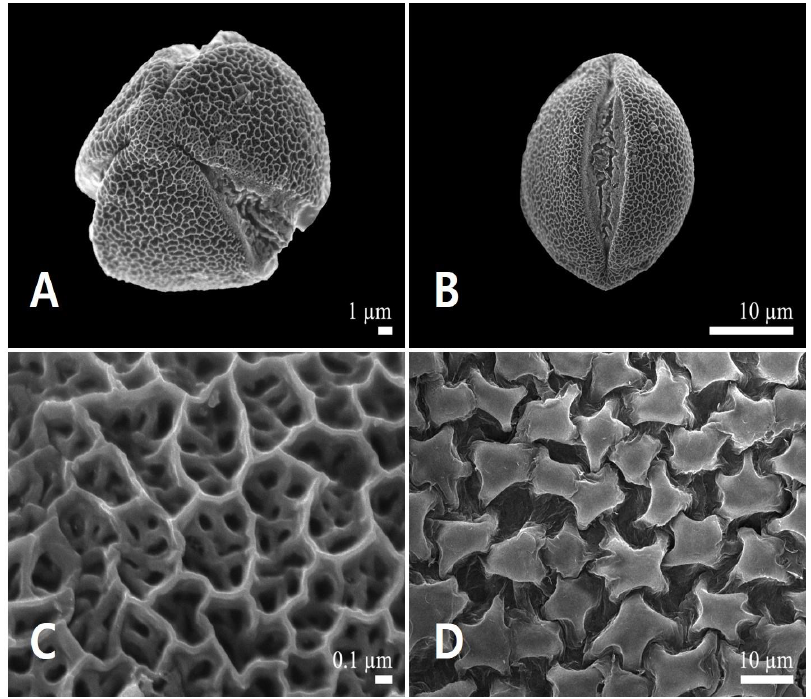
Figure 9. Scanning electron micrographs of pollen and the inner locule wall in Leonurus macranthus . ( A ) Polar view of a pollen grain. ( B ) Equatorial view of a pollen grain. ( C ) Exine surface ornamentation. ( D ) Inner locule wall. 3.3. Floral Trichome Diversity Trichome characteristics, such as distribution, type, length, density, and surface or- namentation, were verified. Three basic types of trichomes were observed on the calyx lobe and tube, upper and lower lips, and filament: capitate stalked glandular trichomes, peltate glandular trichomes, and non-glandular simple trichomes. Scale-like glandular tri- chomes were found only on the anther. 3.3.1. Glandular Trichomes Three shapes of glandular trichomes were identified: capitate stalked, peltate, and scale-like glandular trichomes. Capitate stalked glandular trichomes ( C , Figures 2A,B,D – F,H and 3C,D) had one (Figures 3C and 10D), three (Figure 10B), four (Figure 3D), or eight cells (Figure 5D), a 10 – 20 μm diamet er head, and a short stalk cell up to 20 μm in height. Their head surface ornamentation could be smooth. They were distributed on the calyces, except on the adaxial side of the tube, abaxial side of the lip, and the filament in L. japonicus and L. macranthus . However, on the adaxial side of the upper lip, this type of trichome was observed only in L. japonicus (Table 3).